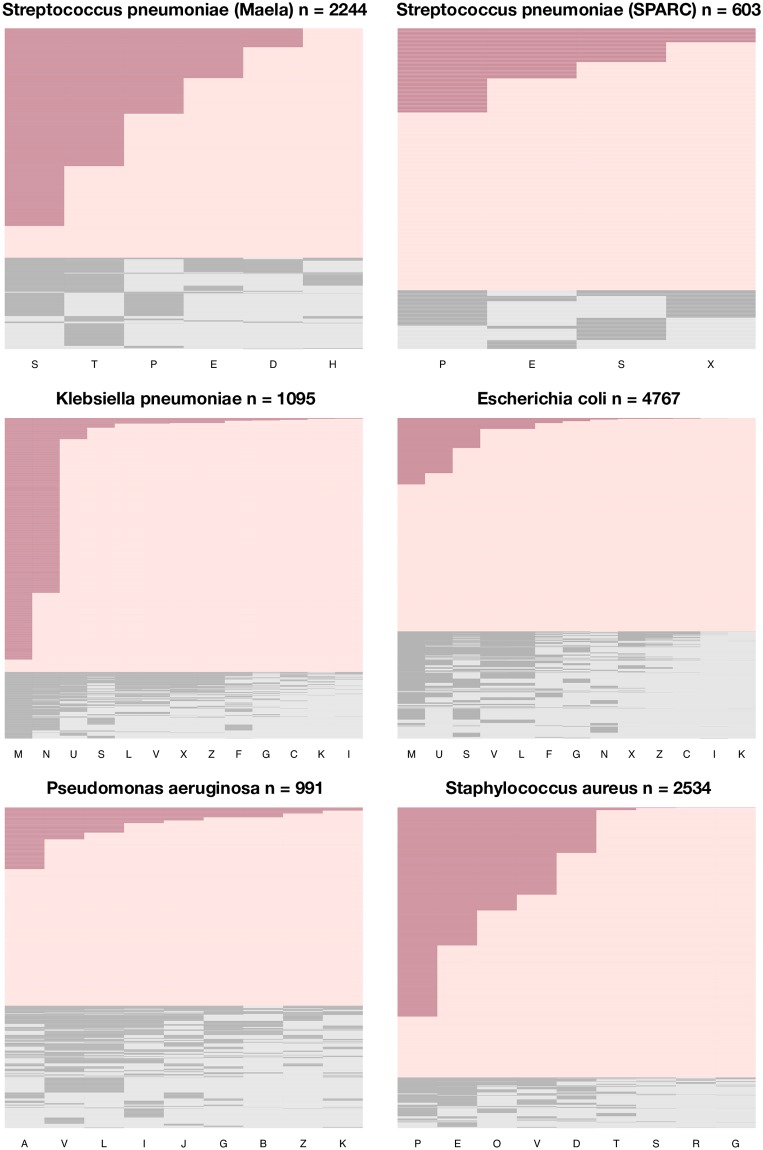
Antibiograms (resistance profiles) in the six bacterial datasets.Dark shading indicates resistance, light shading indicates sensitivity. Antibiograms with a nested structure are coloured red. Each row represents the antibiogram of one isolate (sorted by nestedness and resistance multiplicity). Columns represent antibiotics, ordered by frequency of resistance. A: aztreonam, B: tobramycin, C: cefepime, D: clindamycin, E: erythromycin, F: cefoxitin, G: gentamicin, H: chloramphenicol, I: imipenem, J: piperacillin, K: amikacin, L: ciprofloxacin, M: ampicillin, N: nitrofurantoin, O: oxacillin, P: penicillin, R: rifampin, S: trimethoprim-sulfamethoxazole, T: tetracycline, U: ampicillin-sulbactam, V: levofloxacin, X: ceftriaxone, Z: ceftazidime.